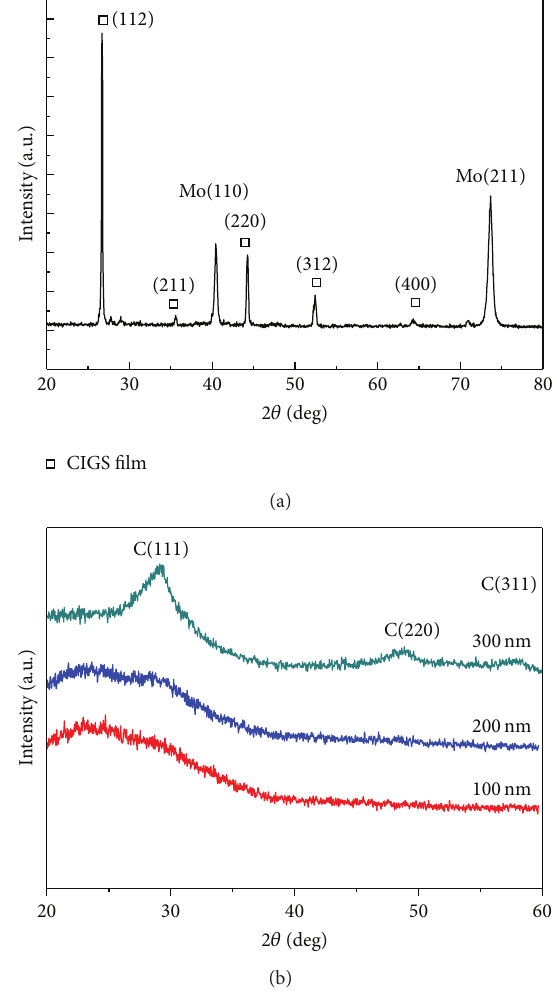
Figure 1: (a) XRD spectra of CIGS film on Mo electrode. (b) XRD spectra of ZnS film synthesized using a chemical bath deposition method at various